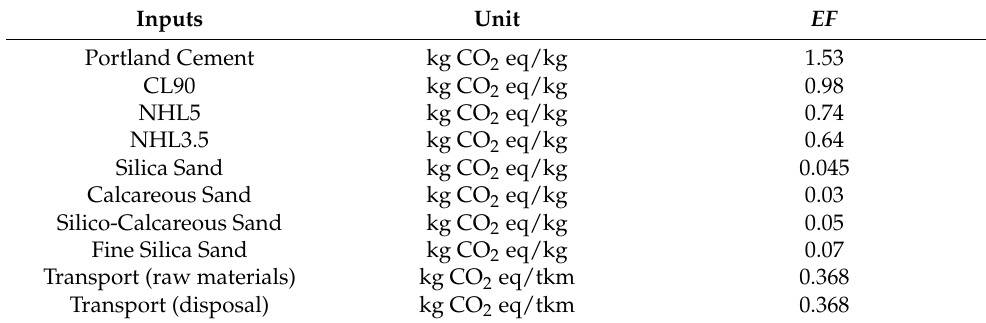
Table 3. Emission factors of inputs [42].